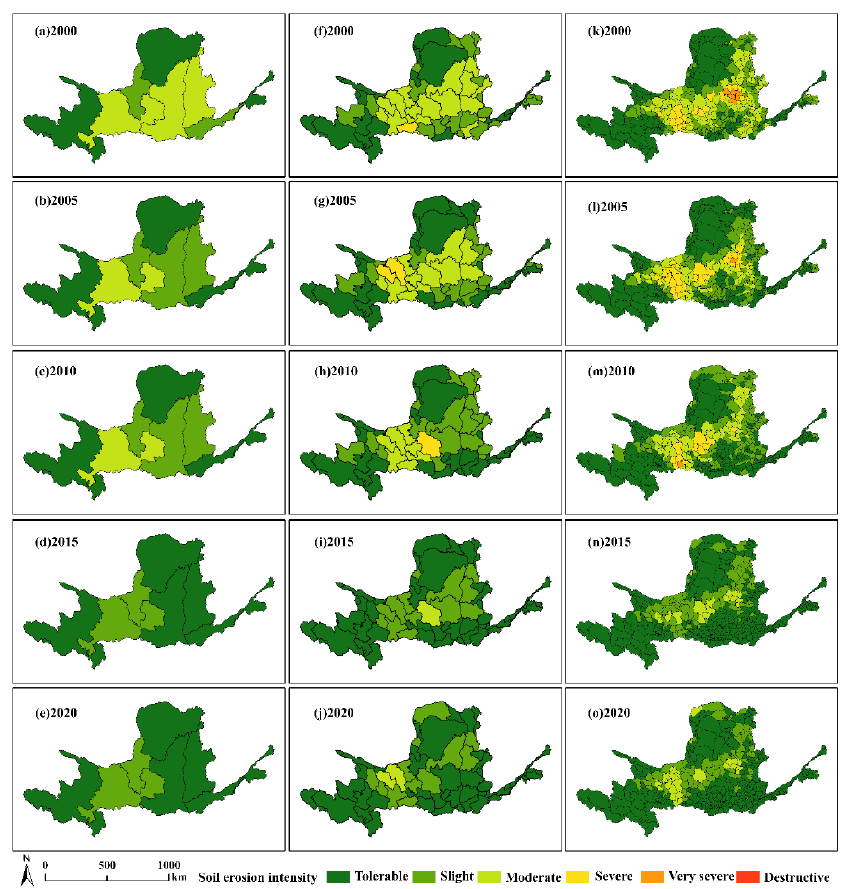
Figure 4. The soil erosion intensity at the ( a – e ) province scale, ( f – j ) city scale, ( k – o ) county scale from 2000 to 2020.